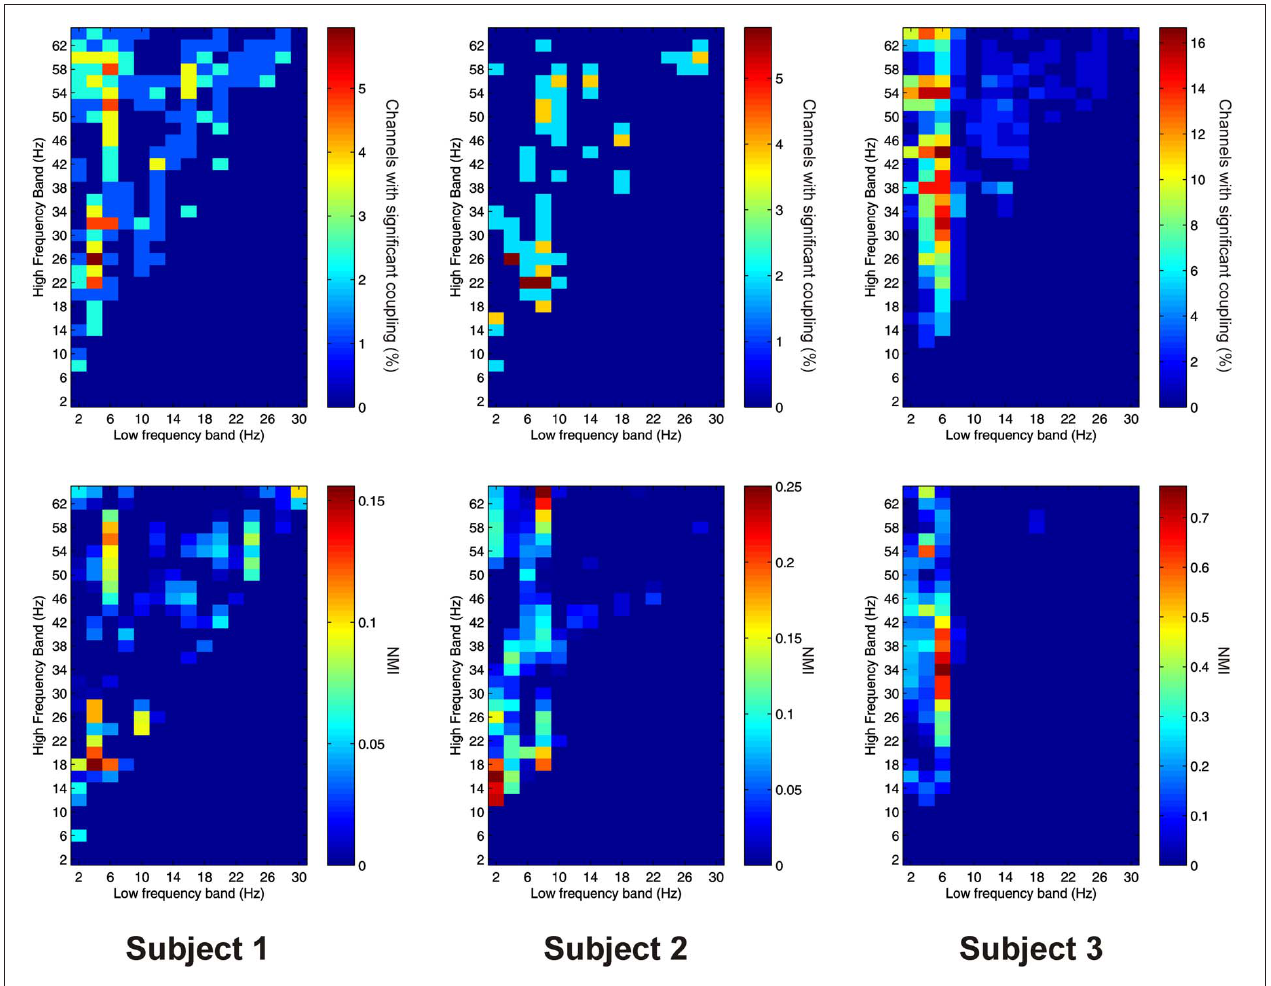
FIGURE 8 | Top row: Proportion of channels showing significant cortico-thalamic PAC (coupling between a low-frequency in the PFC and a high-frequency in the thalamus) (Subject 1 left, Subject 2 middle, Subject 3